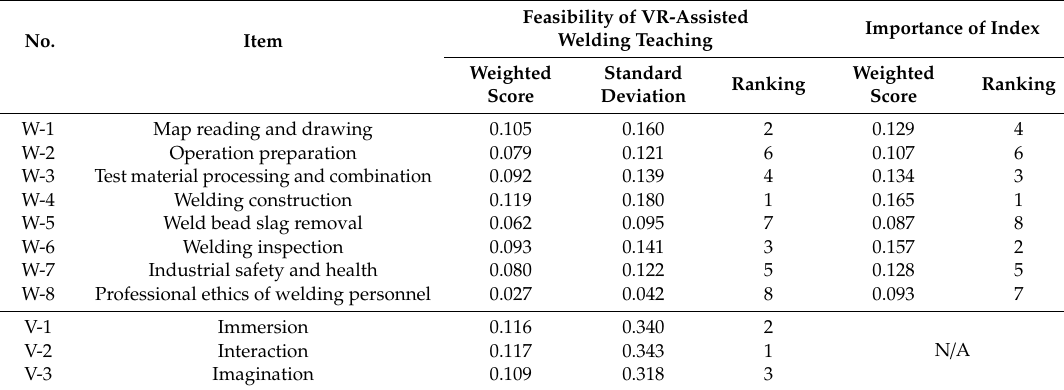
Table 6. Summary of the limited supermatrix of Feasibility and